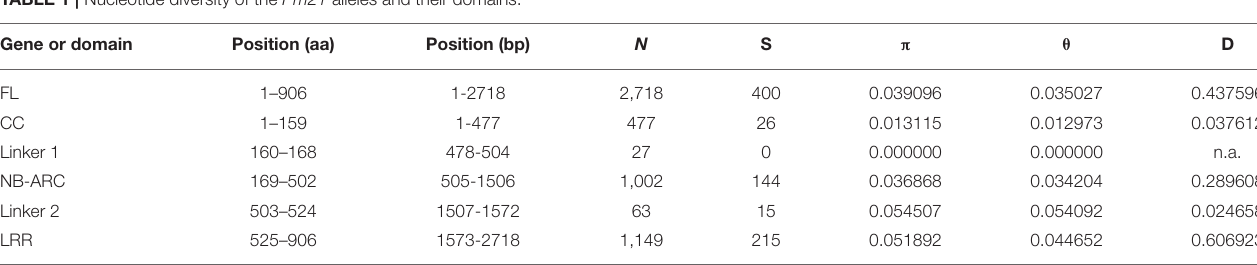
TABLE 1 | Nucleotide diversity of the Pm21 alleles and their